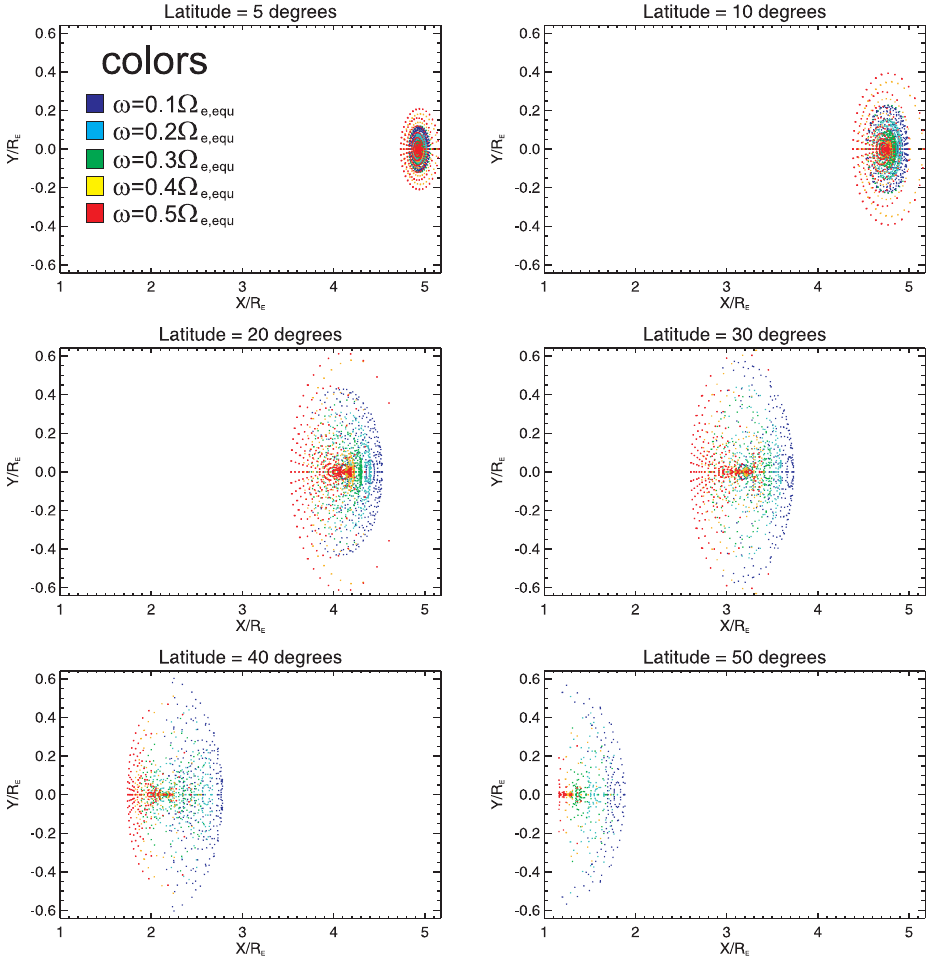
Fig. 3. Spatial divergence of ray trajectories as a function of latitude, with respect to wave frequency. Each ray position intersecting one latitudinal plane ( λ = const) is plotted by a point, whose color represents its frequency, from ω = 0 . 1 (cid:127) e , equ (dark blue) to ω = 0 . 5 (cid:127) e , equ (red) with 1ω = 0 . 1 (cid:127) e , equ . Rays are launched from a single starting point of coordinates [5 R E , 0 , 0], confined in a cone centered around the local magnetic field, with parameters 5 ◦ ≤ θ 0 ≤ θ res and − 180 ◦ ≤ ϕ 0 ≤ + 180 ◦